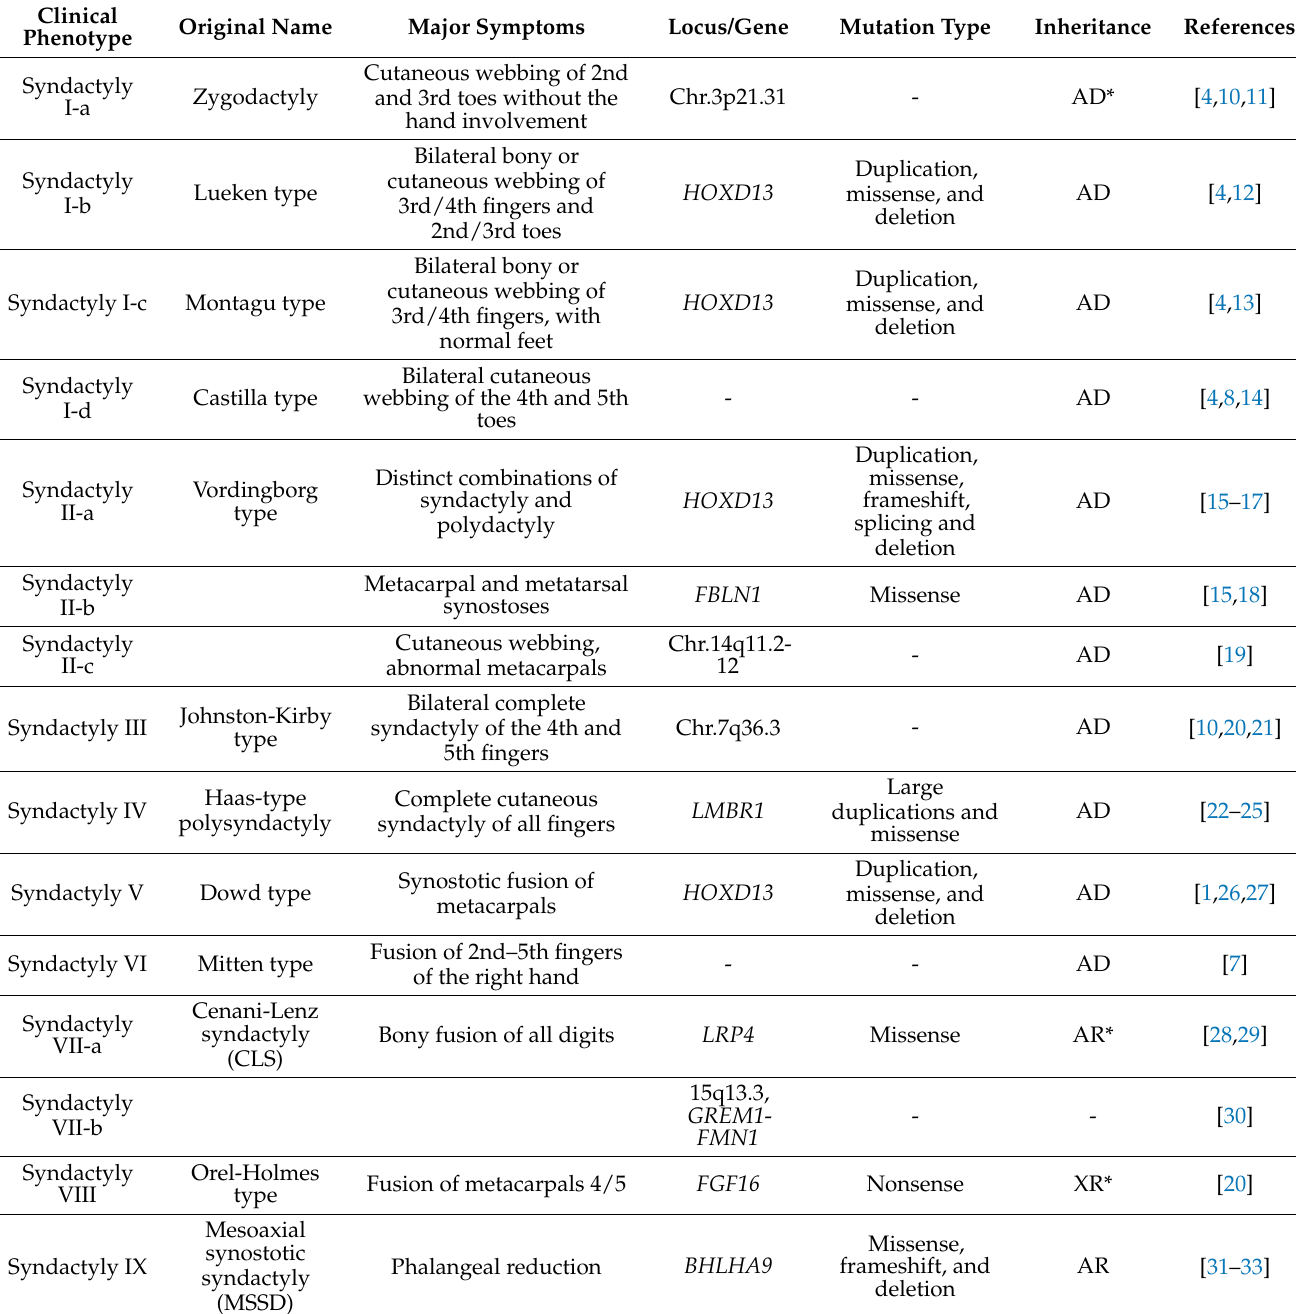
Table 1. List of genes and loci responsible for different types of non-syndromic